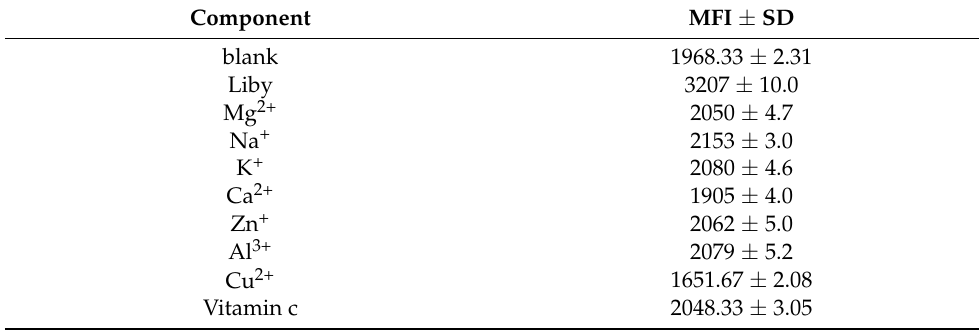
Table 1. Fluorescence enhancement of CQDs under different treatments.